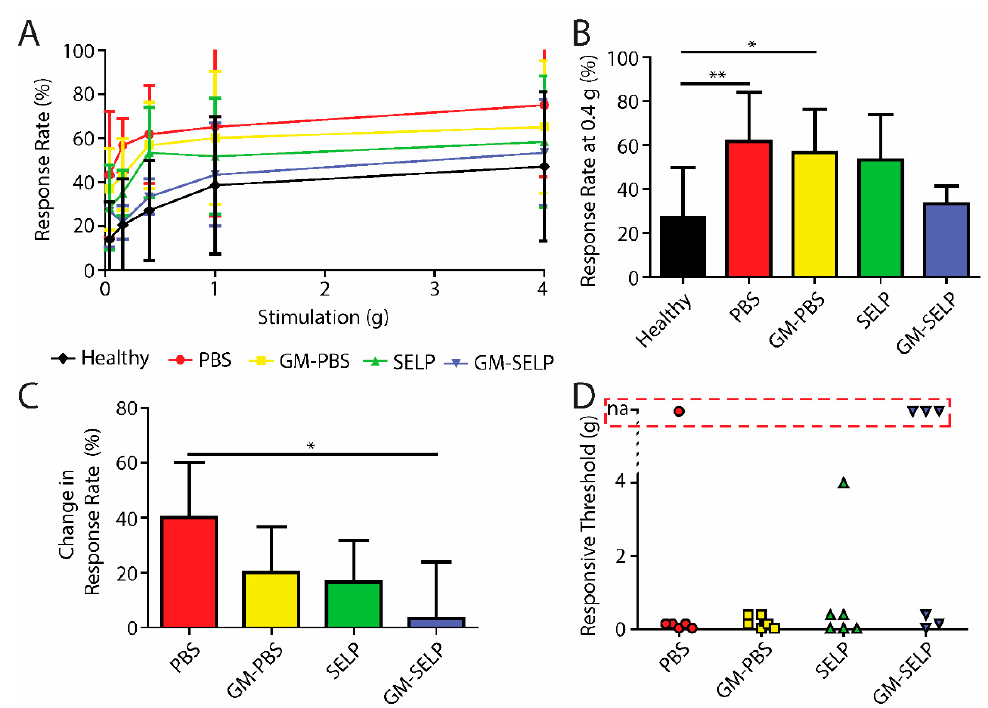
Figure 1. Behavioral pain responses 3-day post irradiation. ( A ) Response rates of irradiated animals receiving selected treatments and healthy controls. ( B ) Response rates with the 0.4-g filament. ( C ) Change in response rates from baseline measurements with the 0.16-g filament. ( D ) Threshold required to elicit an allodynic response as measured by an increase in 30% from the baseline. Red box indicates animals with no allodynic response (na) (** p < 0.01, * p < 0.05).